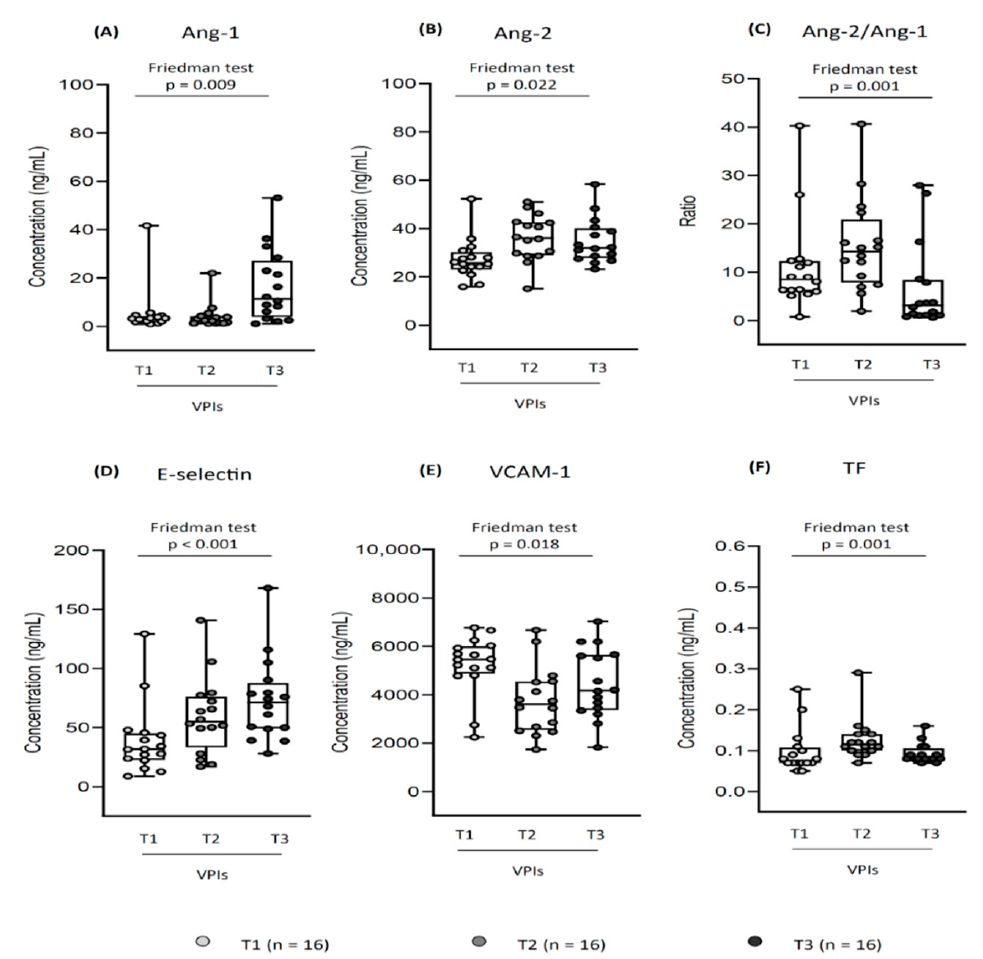
Figure 2. Soluble endothelial markers profile in very preterm infants (VPIs): relationship between T1, T2, and T3. Each dot represents a neonate, each box whisker plot shows the median, interquartile range and range; only infants with 3 available measurements were considered (n = 16); concentrations are expressed in ng/mL, Ang-2/Ang-1 is expressed as a ratio. ( A ) Ang-1 increased from T1 to